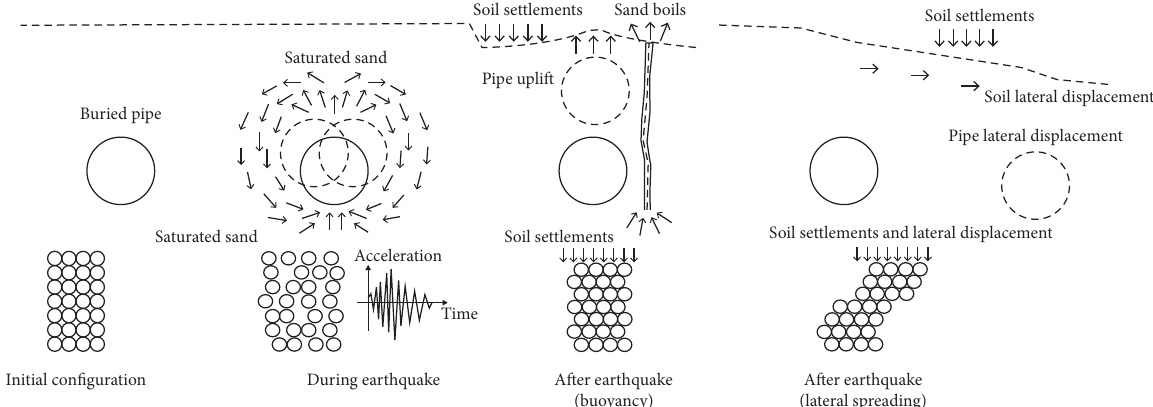
Figure 1: Simplified scheme of liquefaction-induced effects on buried